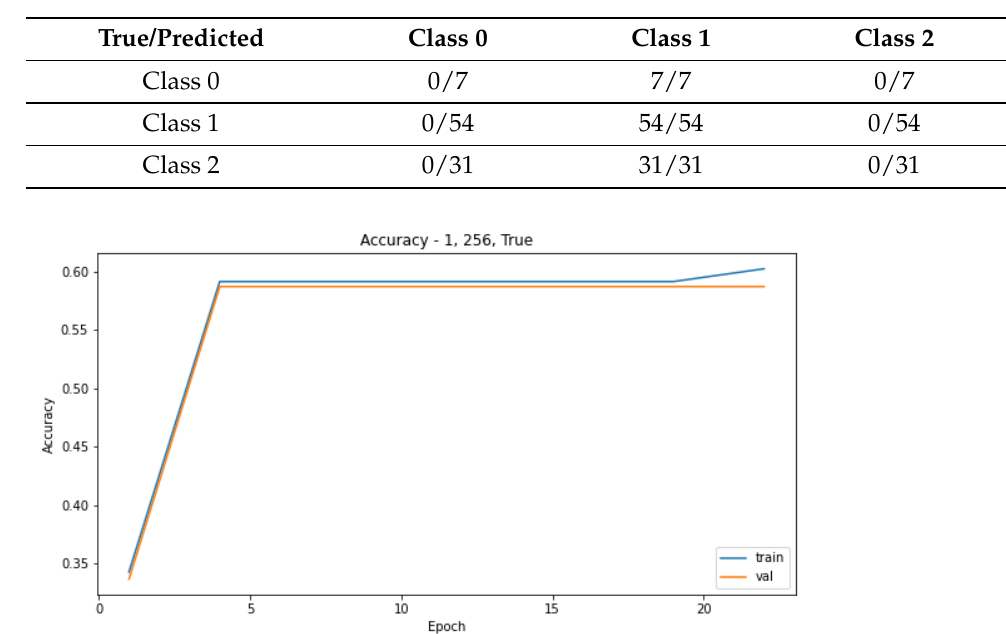
Table 3. Confusion matrix for CNN Model on validation set trained on original dataset (274 observations).